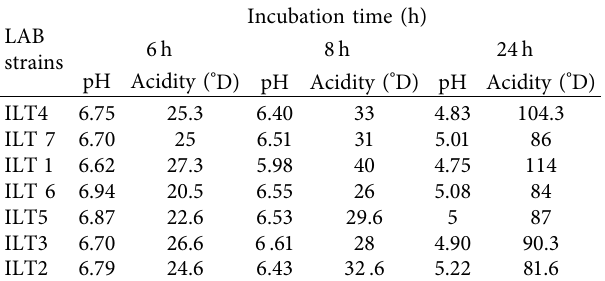
Table 3: Acidifying activity of selected LAB